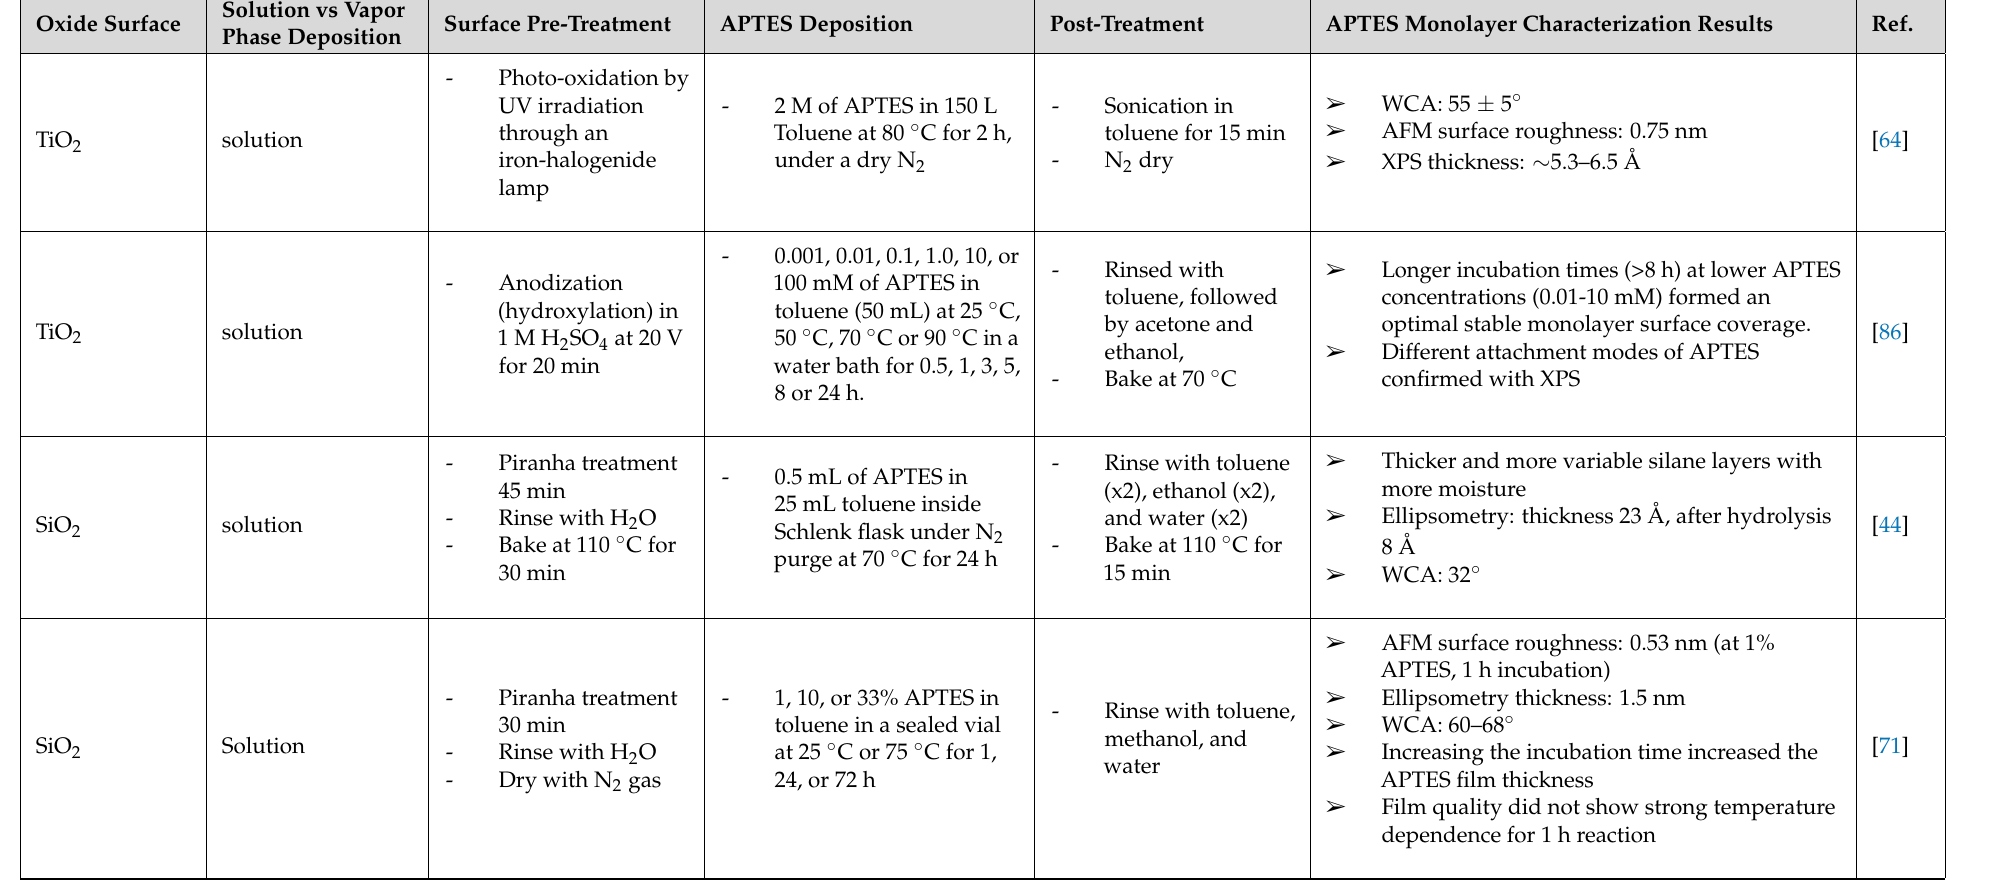
Table 2. APTES grafting methods and characterization results on oxide